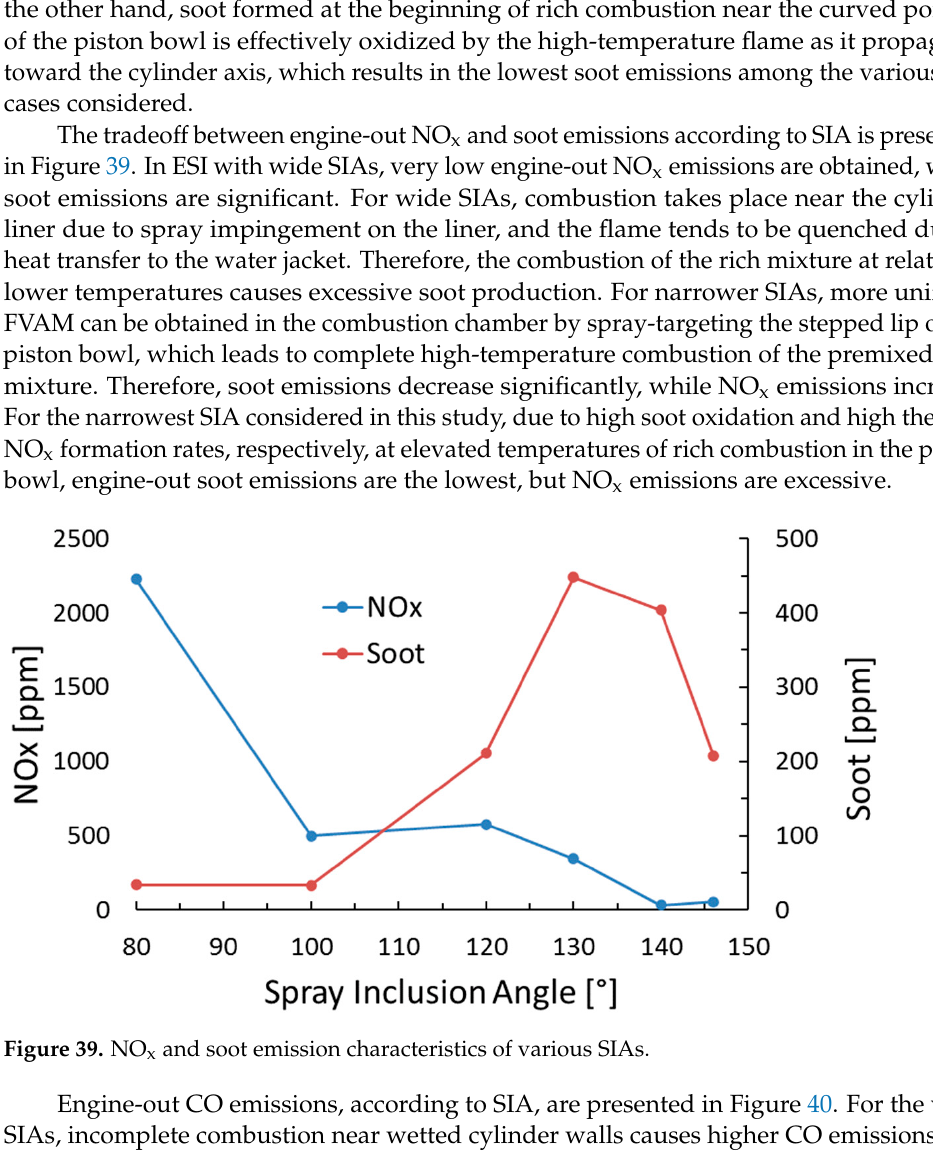
Figure 40. CO emission characteristics of various SIAs. CE and IMEP for various SIAs are presented in Figure 41. For wide SIA cases of 146°, 140°, and 130°, CEs are 84.3%, 78.9%, and 81.5%, respectively; while for narrow SIA cases of 120°, 100°, and 80°, CEs are 91.3%, 97.8%, and 96.3%, respectively. CE severely deterio- rates due to incomplete combustion of the inadequately mixed fuel vapor with air at low temperatures for wide SIA cases. The lowest CE of 78.9% occurs for the SIA of 140° due to incomplete rich combustion of the poorly mixed fuel vapor with air in both the squish region and crevice at flame temperatures ranging between 1500 K and 2000 K after spray impingement on the cylinder liner.